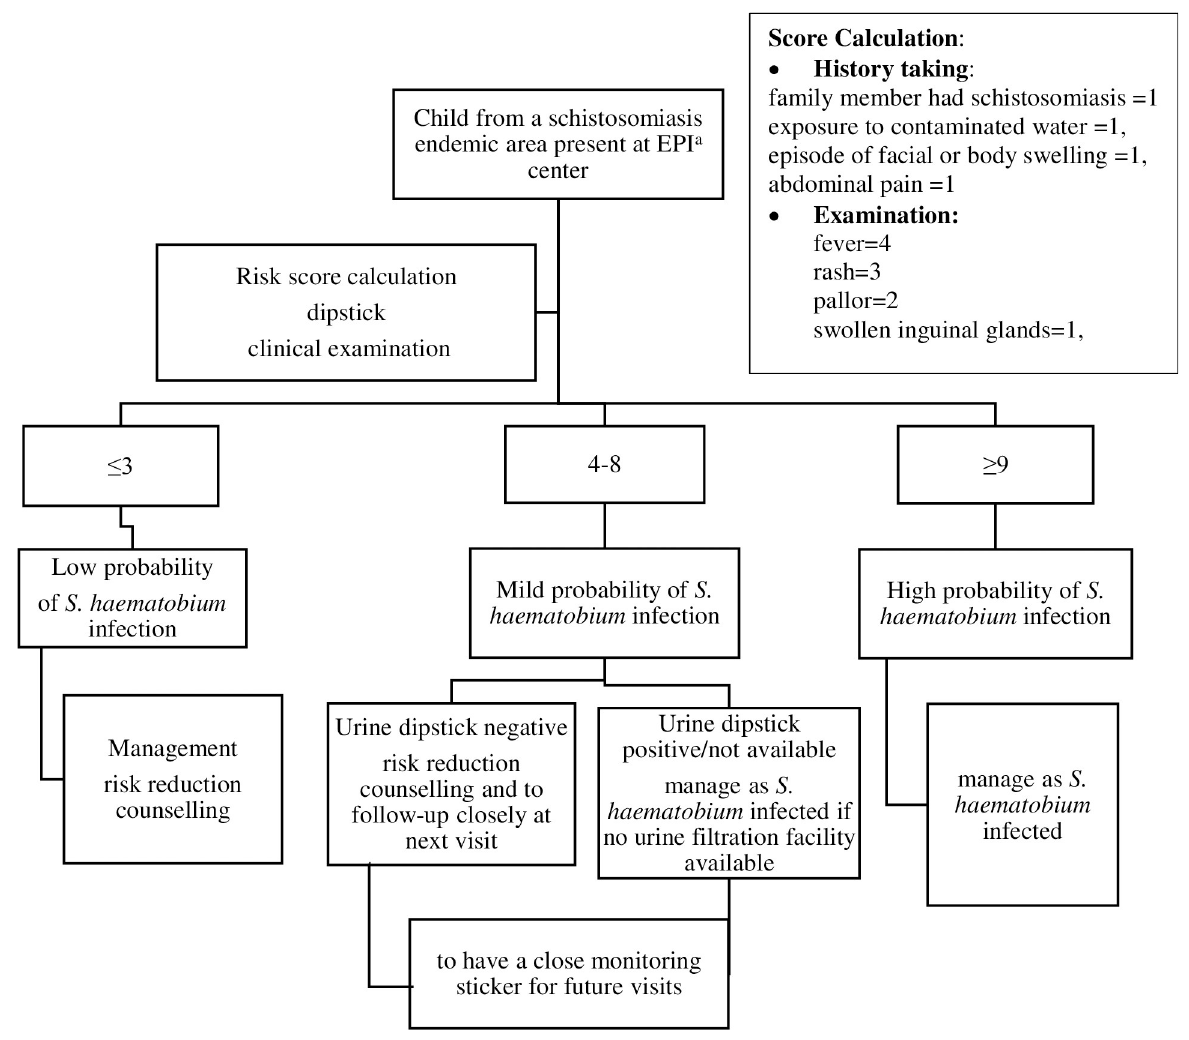
Fig 3. The Algorithm for S . haematobium Diagnosis and Management for Early Schistosomiasis Infection in Preschool Age Children in Resource Limited Settings. https://doi.org/10.1371/journal.pntd.0009599.g003 penetration sites [13]. These signs are self-limiting in a few days. In the chronic phase, cutane- ous lesions observed consists of granuloma clusters located in the dermis part of the skin [28]. Caregivers of the ESI participants also reported facial/body swelling with urticaria in their chil- dren at baseline. Other causes of swelling were eliminated and 75% of the children had no self